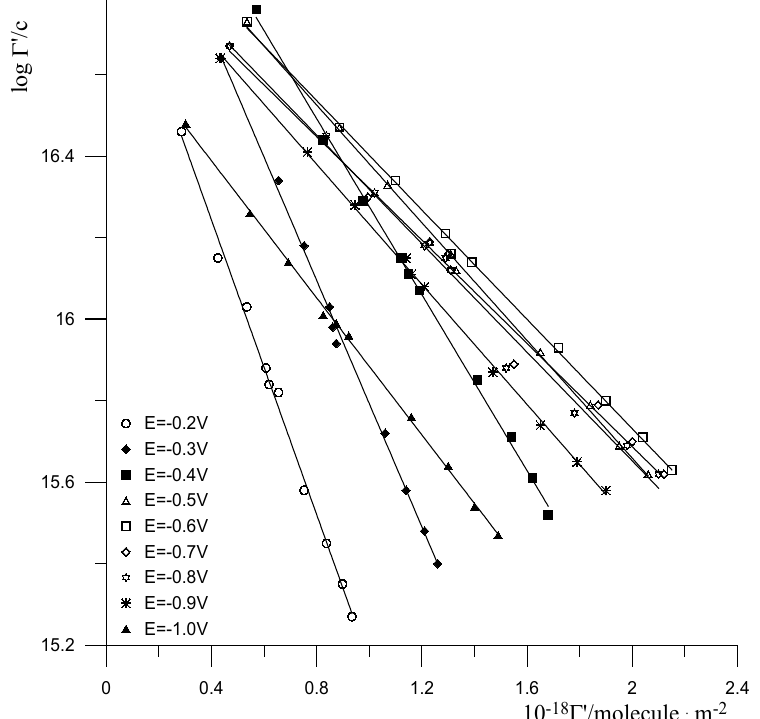
Figure 6. A linear test of the virial isotherm for the system 3 mol dm -3 NaClO